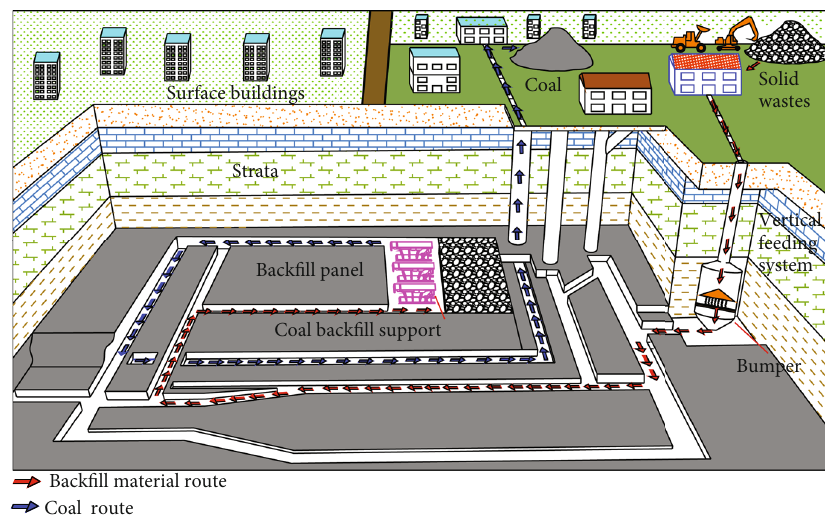
Figure 7: The method schematic of solid back fi ll mining in a coal